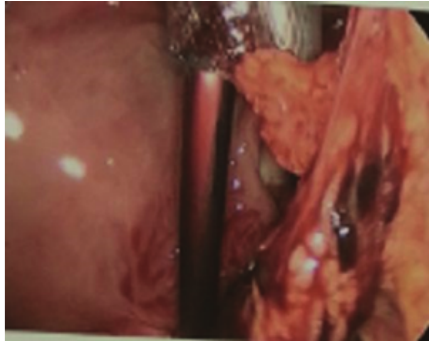
Figure 3: Omental adhesion close to the right adnexa with